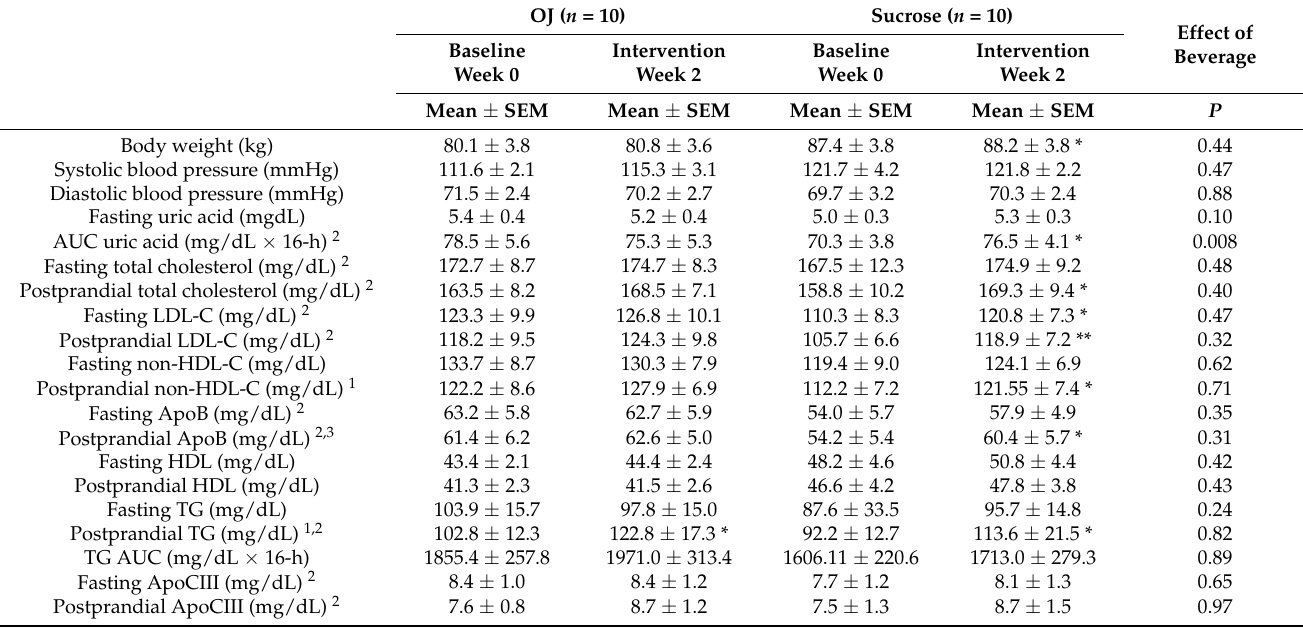
Table 2. Body weight and cardiometabolic risk